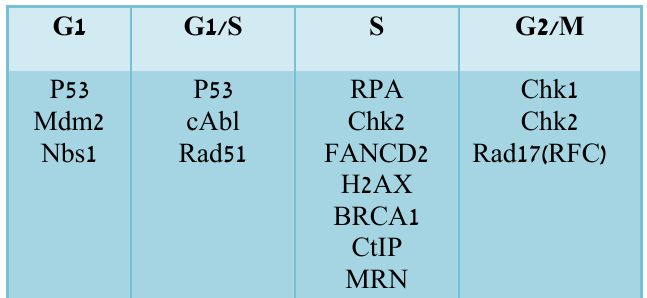
Table 2. ATM substrates in different phases of the cell cycle [14,